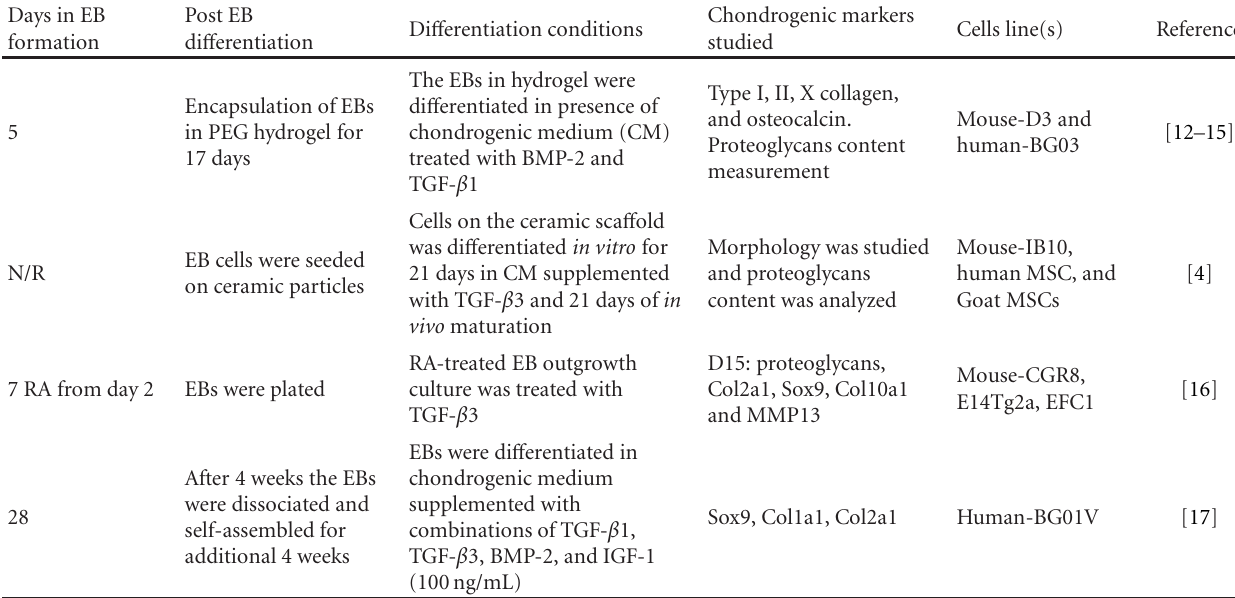
Table 1: In vitro models for direct di ff erentiation of embryonic stem cells to chondrogenic lineages. Days in EB